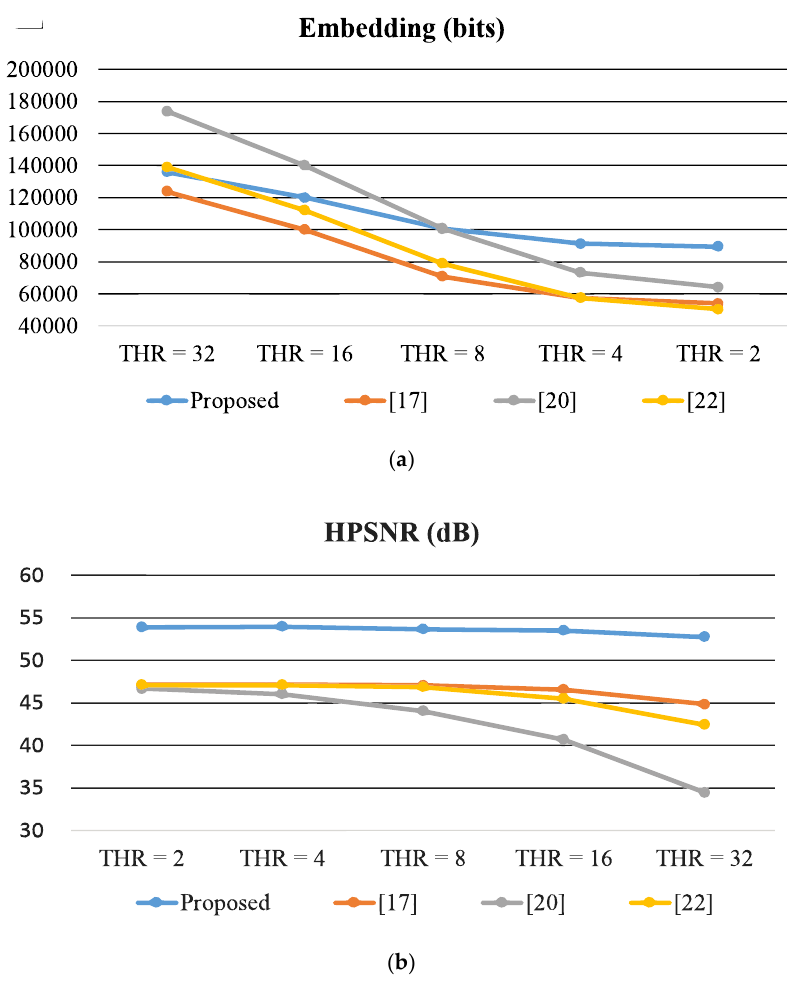
Figure 7. Comparison of the variation of the usage of different thresholds. ( a ) Results of data capacity. ( b ) Results of Human Vision System-based Peak Signal-to-Noise Ratio (HPSNR) value.